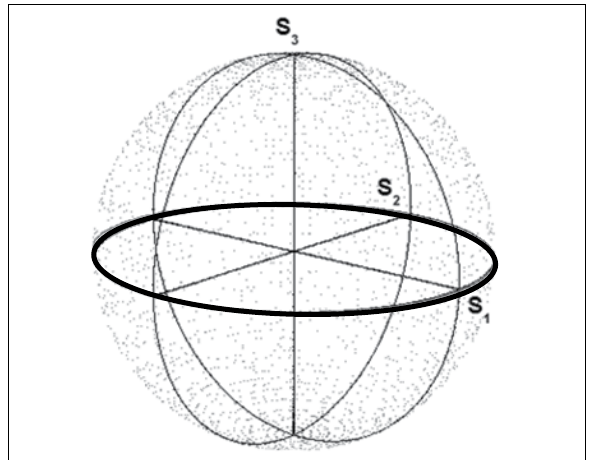
Figure 5: This figure shows the compensation of all four states used in the quantum key distribution protocol using one polarisation controller. The S1 axis represents the rectilinear basis, the S2 axis represents the diagonal basis and the S3 axis represents the circular basis. The bold line in the figure, indicated on the equator of the Poincaré sphere, shows that only linear states of polarisation were measured, thus eliminating any ellipticity induced in the fibre